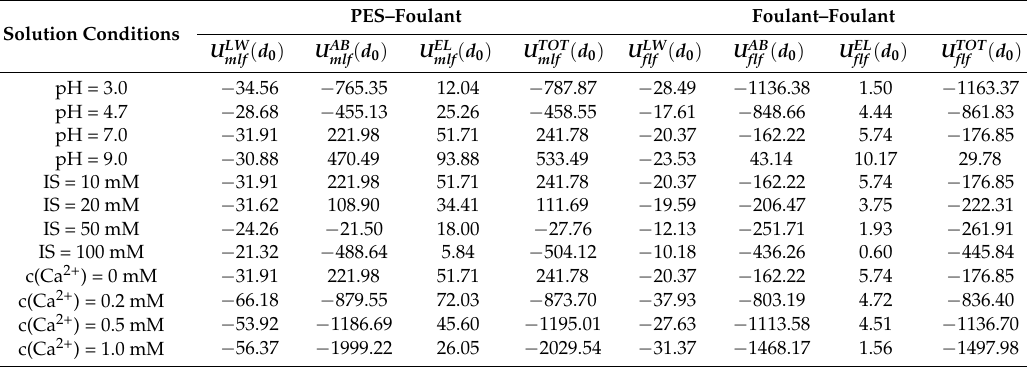
Table 3. The calculated interfacial interaction energies (kT) of PES–foulant and foulant-foulant combinations at different solution conditions. LW, AB, and EL represent the Lifshitz–van der Waals, acid–base, and electrostatic contributions to energy, respectively, while m , l , and f represent the contact involving membrane, liquid, and foulant, respectively; d 0 is the minimum equilibrium cut-off